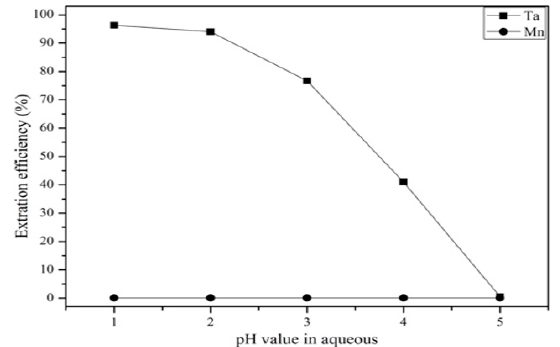
Figure 9. Effect of different pH values on the extraction efficiency. Concentration: 0.01 mol/L. Extraction time: 5 min. A/O = 1.